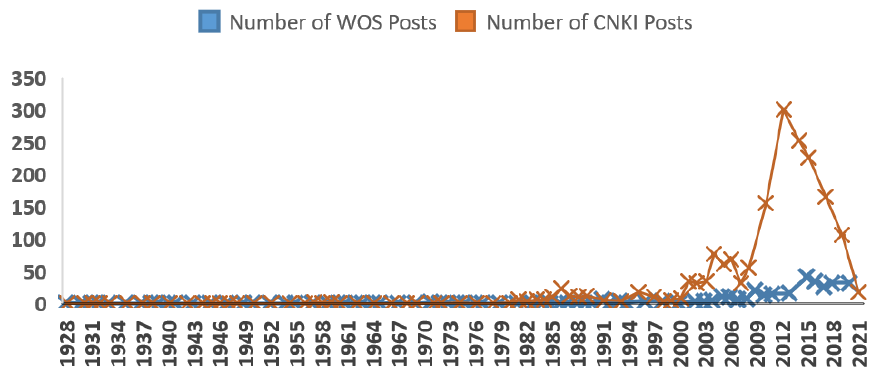
Figure 1. Statistical Chart of Publications.